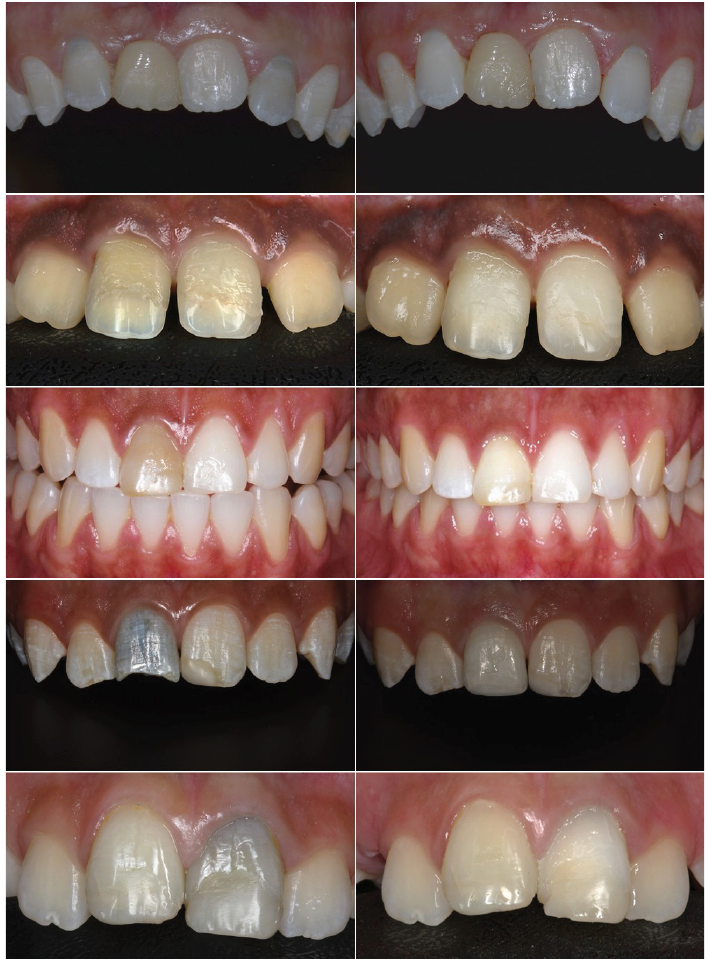
Figure 3. Clinical appearance of the cases included in the study. (A,C,E,G,I) Clinical appearance before internal bleaching, where it is possible to observe the crown discoloration of the incisors submitted to the regenerative endodontic procedure; (B,D,F,H,J) Clinical appearance 14 days after the last internal bleaching